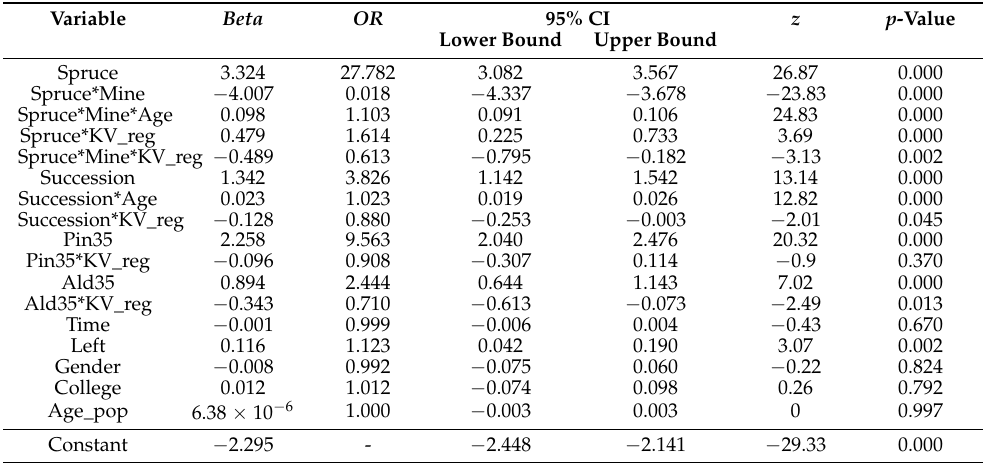
Table 4. Multinomial logistic regression